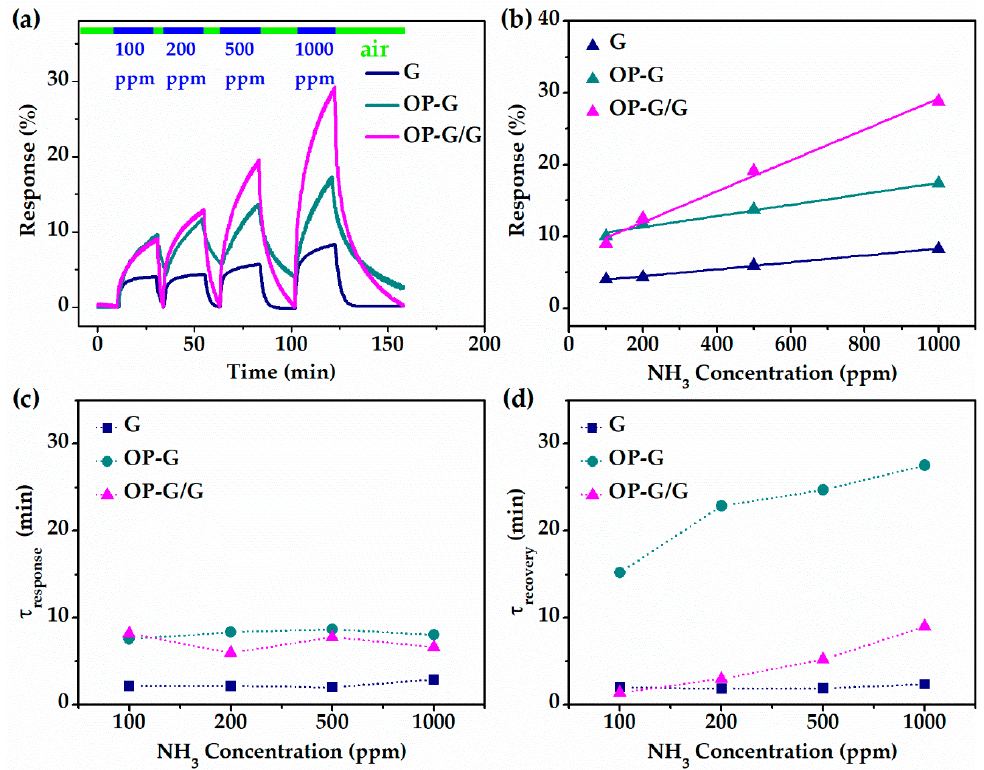
Figure 4. The relative NH 3 gas sensing test results of G, OP-G and OP-G/G based sensors. ( a ) Response curves at different concentrations of NH 3 . ( b ) Sensitivity of three gas sensors. ( c ) Response and ( d ) recovery time constant of three gas sensors.